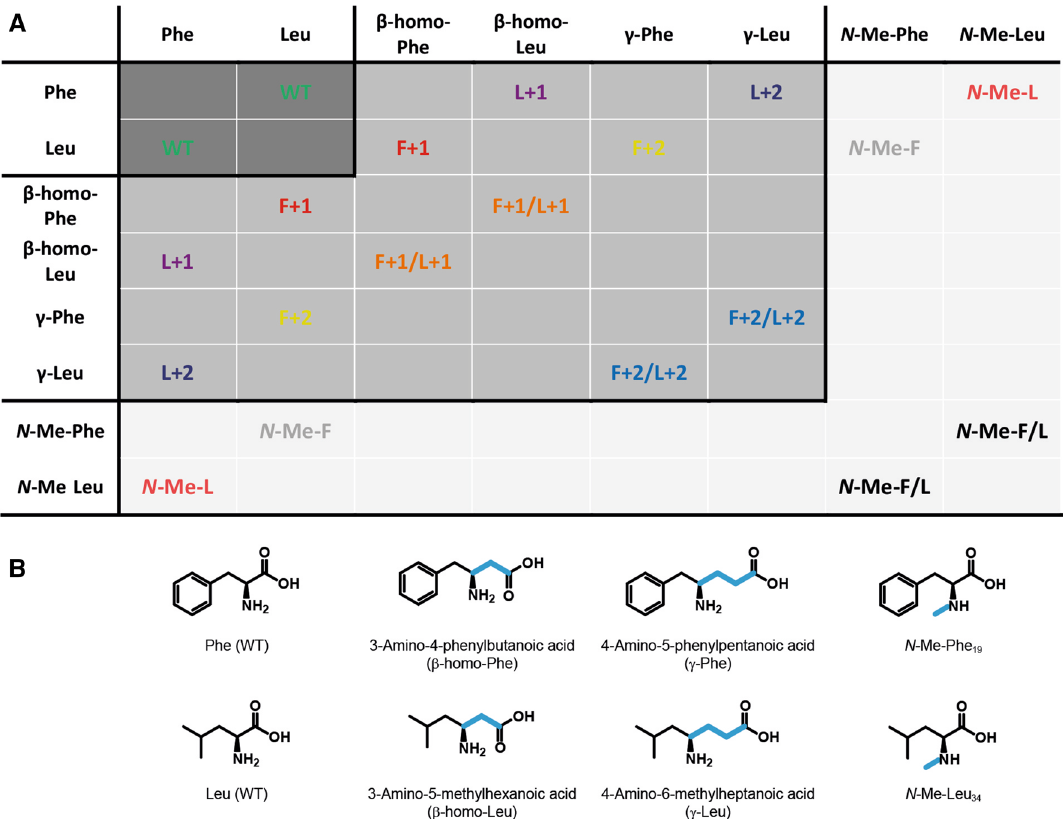
Figure 2. ( A ) Summary of the backbone mutation scheme applied to Aβ 40 peptides used in this study. The color code is used throughout the manuscript in the respective data. ( B ) Chemical structure of the backbone modified amino acids introduced into positions 19 and 34,